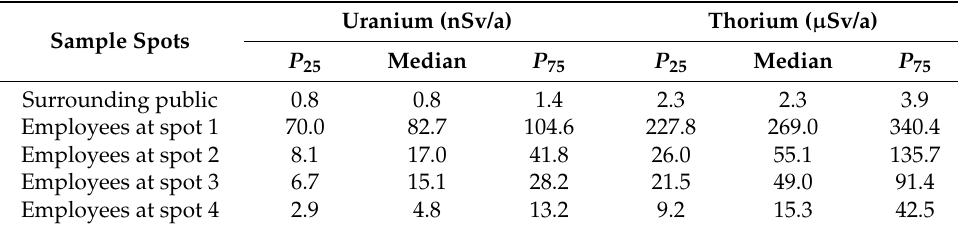
Table 2. Effective dose of uranium and thorium inhaled by workers and the public. Uranium (nSv/a) Thorium ( µ Sv/a) Sample Spots P 25 Median P 75 P 25 Median P 75 Surrounding public 0.8 0.8 1.4 3.9 Employees at spot 1 70.0 82.7 Employees at spot 2 Employees at spot 3 Employees at spot